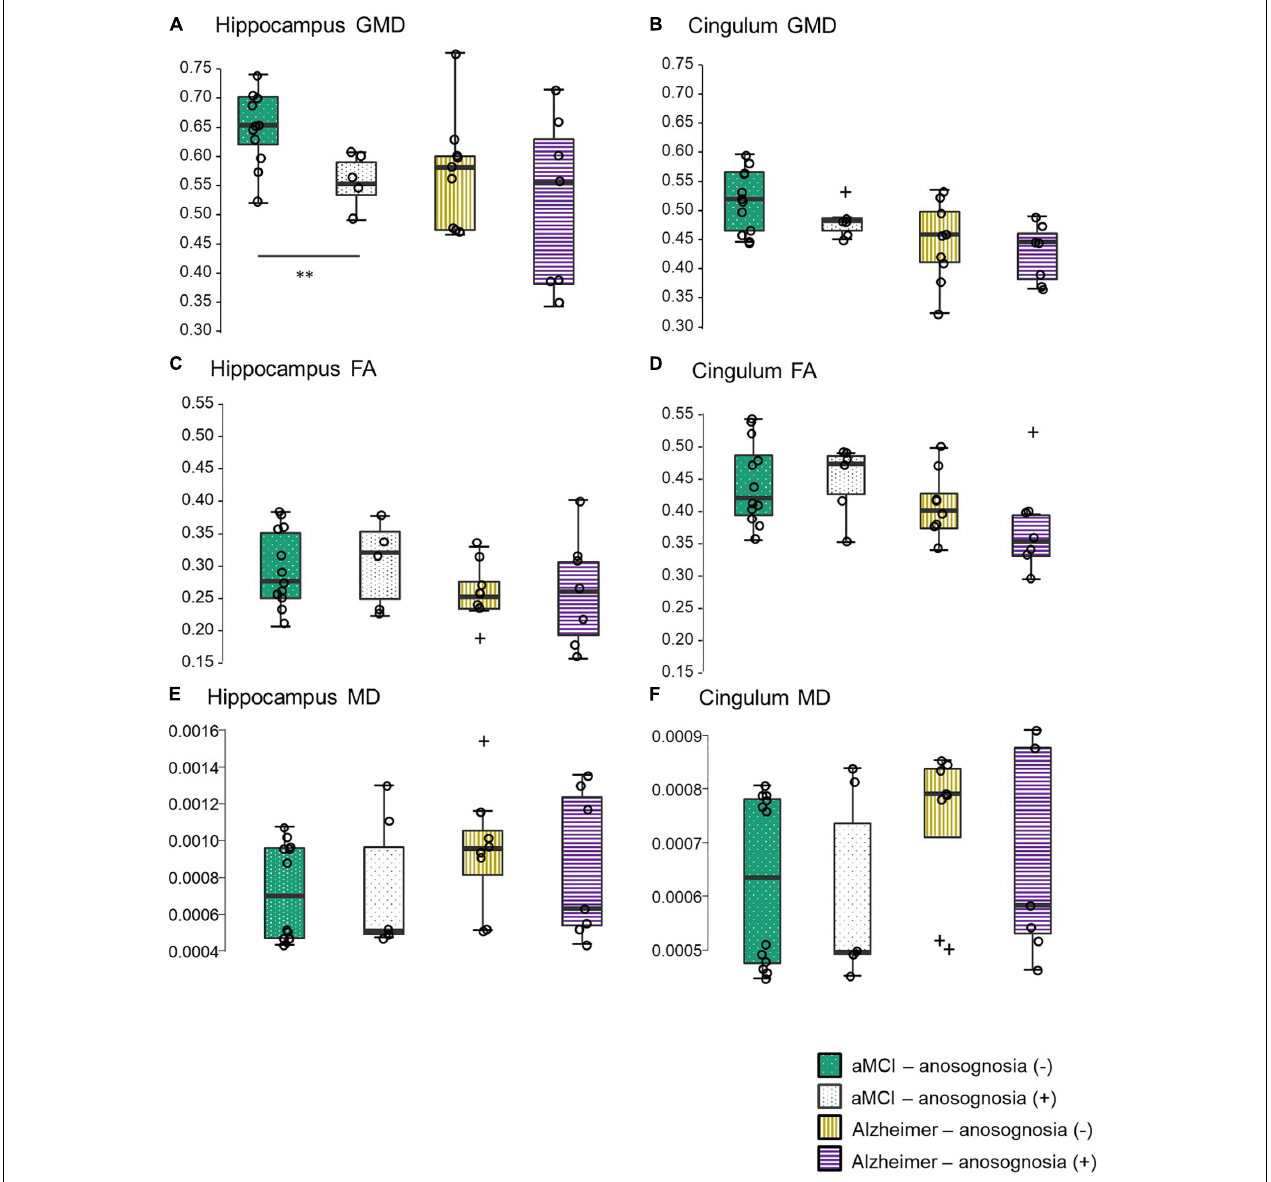
FIGURE 2 | Gray matter density in the hippocampal and cingulum regions of interest in aMCI subjects with and without anosognosia, and AD dementia participants. aMCI subjects with anosognosia displayed significantly less hippocampal gray matter density than aMCI subjects without anosognosia (** p = 0.01). The hippocampal gray matter density of aMCI subjects with anosognosia was not statistically different from participants with AD dementia. Boxplots represent mean group values and interquartile ranges, outliers (values outside the lower of upper limits of the quartile range) are represented with the symbol +. GMD, gray matter density; FA, fractional anisotropy; MD, mean diffusivity; aMCI, amnestic mild cognitive impairment; AD, Alzheimer’s disease. Although most of these correlations were not significant, there are trends shown in Supplementary Figure 1 that could inform future research, particularly the negative correlation between anosognosia scores and FA in both ROIs shown in AD participants. If replicated, this suggests that white-matter integrity disturbances could result in a more pronounced anosognosia presentation in